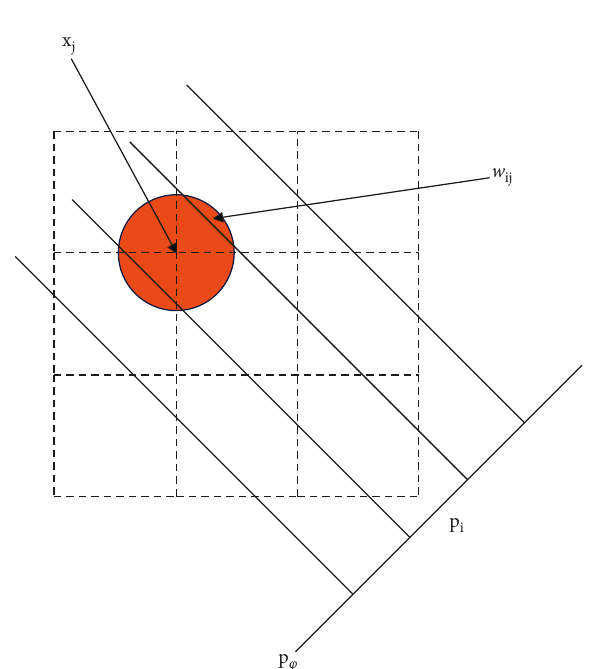
Figure 9: Schematic diagram of SART projection matrix